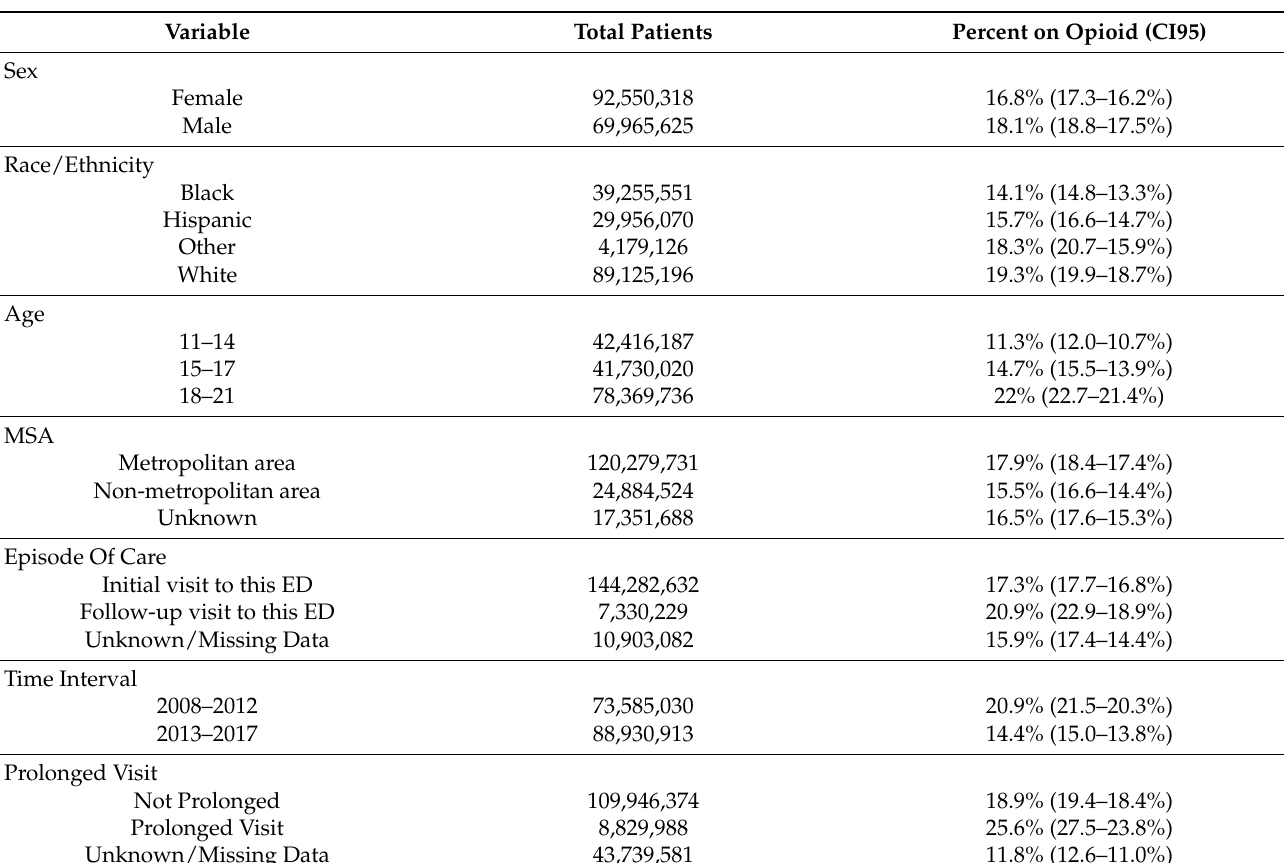
Table 1. Demographic Characteristics of a Weighted Sample of Adolescent Emergency Department Visits in the US from 2008 to 2017 a